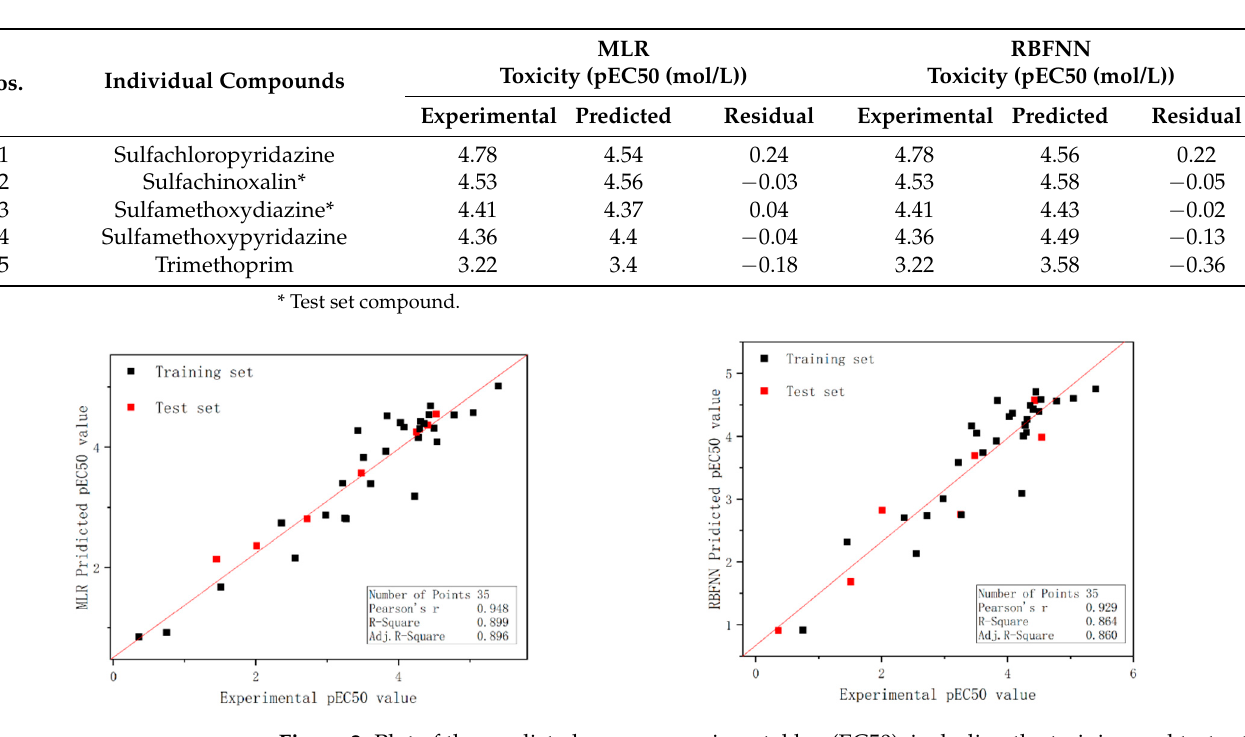
Figure 2. Plot of the predicted versus experimental log (EC50), including the training and test sets, from the MLR model and RBFNN model. Table 3. Inter-correlation between the five descriptors.